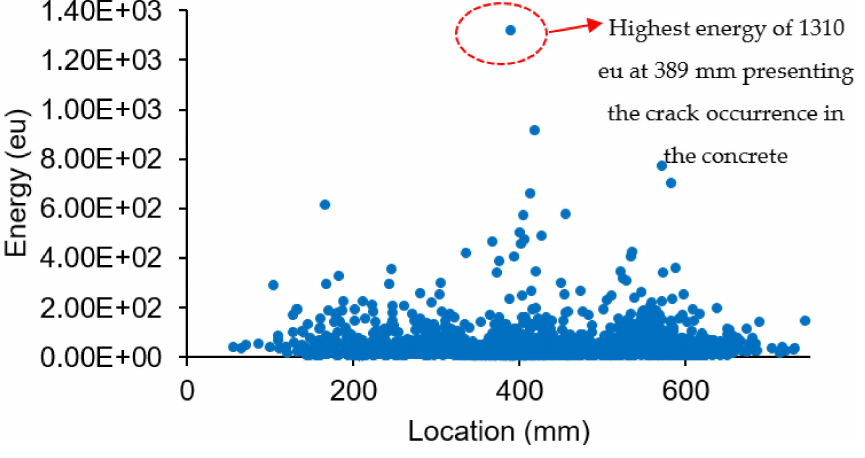
Figure 14. Energy distribution with respect to location.